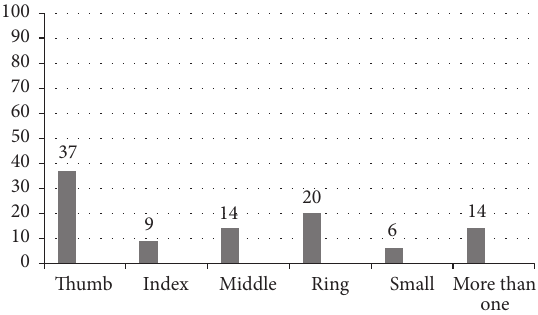
Figure 1: Distribution of Trigger finger